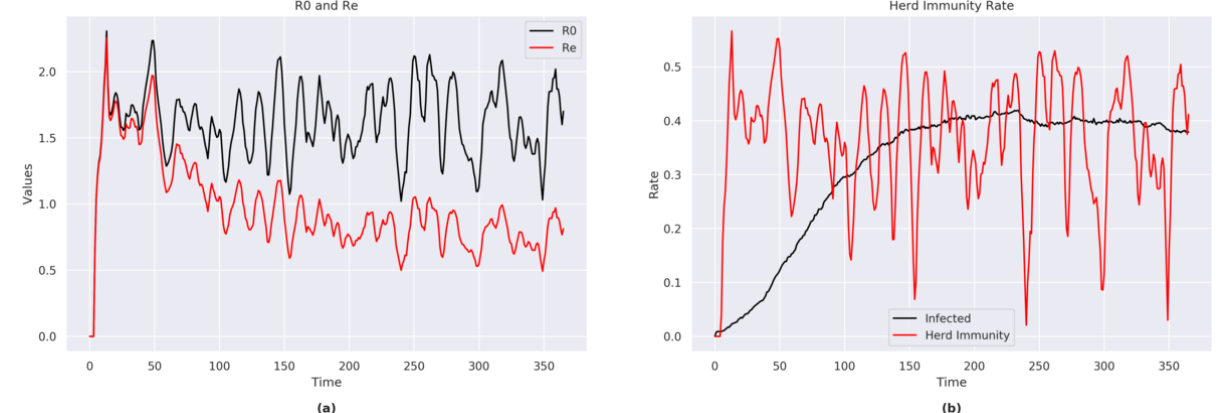
Figure 6. (a) R 0 and R e indexes for Sweden. (b) Herd immunity rate for Sweden.